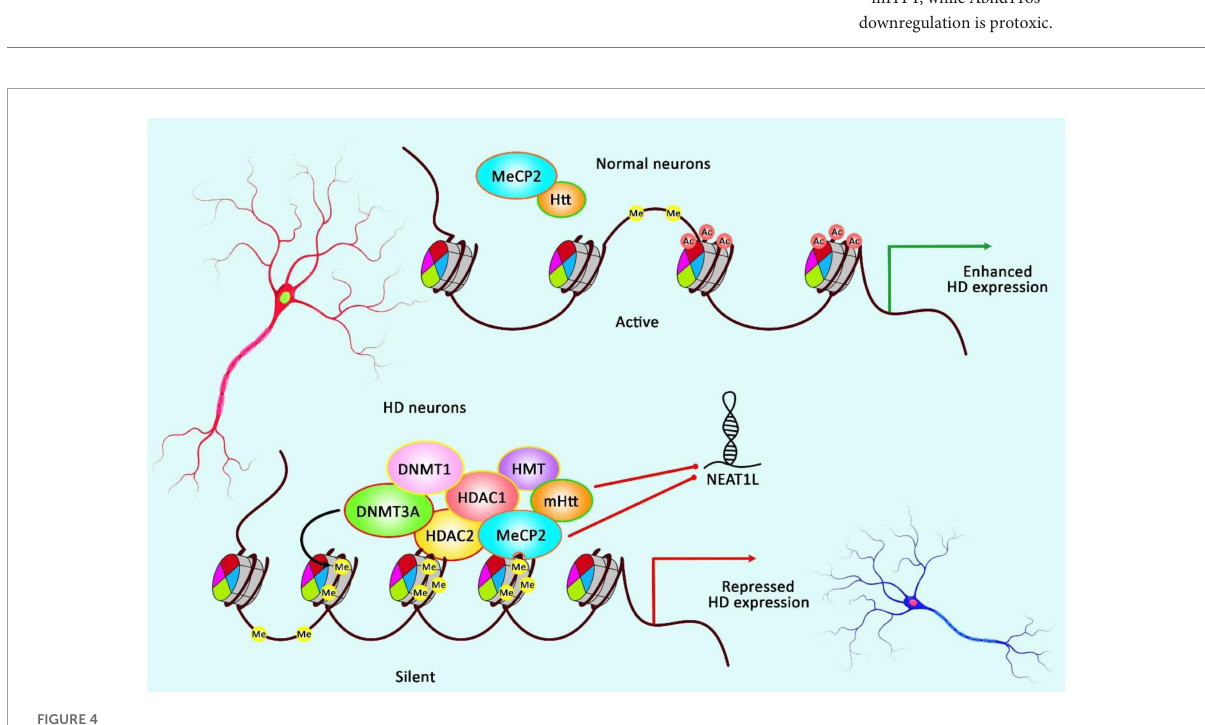
FIGURE4 A schematic illustration of the role of NEAT1L in